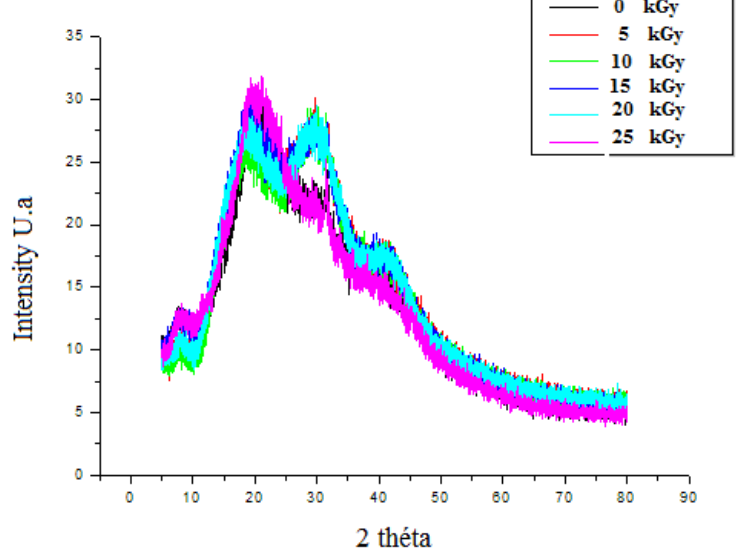
Figure 8. X-ray diffractograms of irradiated gelatine–chitosan–Pomegranate peel (GEL–CH–PP) composite of with different γ -radiation doses, 5, 10, 15, 20, and 25 kGy, in comparison with control samples (0 kGy).